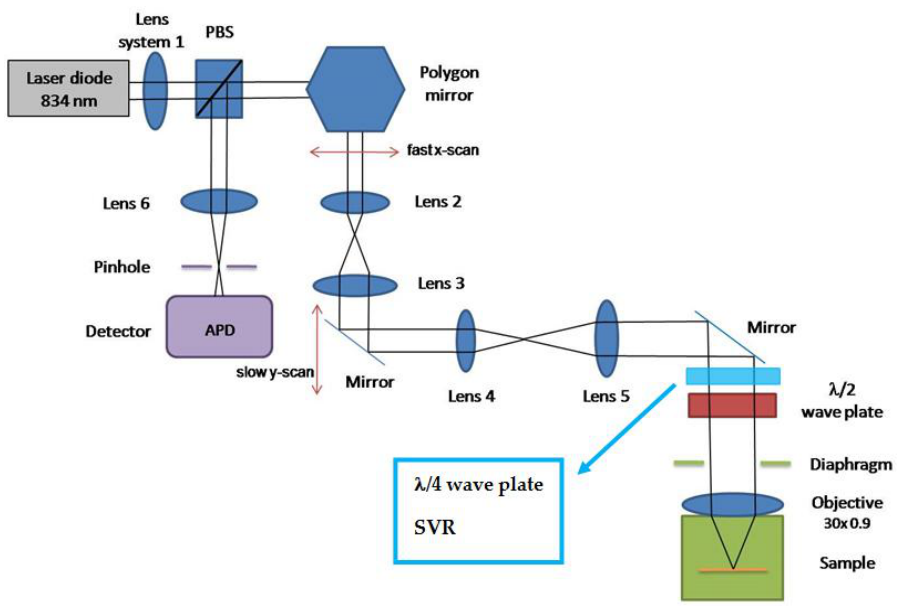
Figure 1. Schematic diagram of cross-polarized confocal laser scanning microscope used for ex-vivo and in-vivo